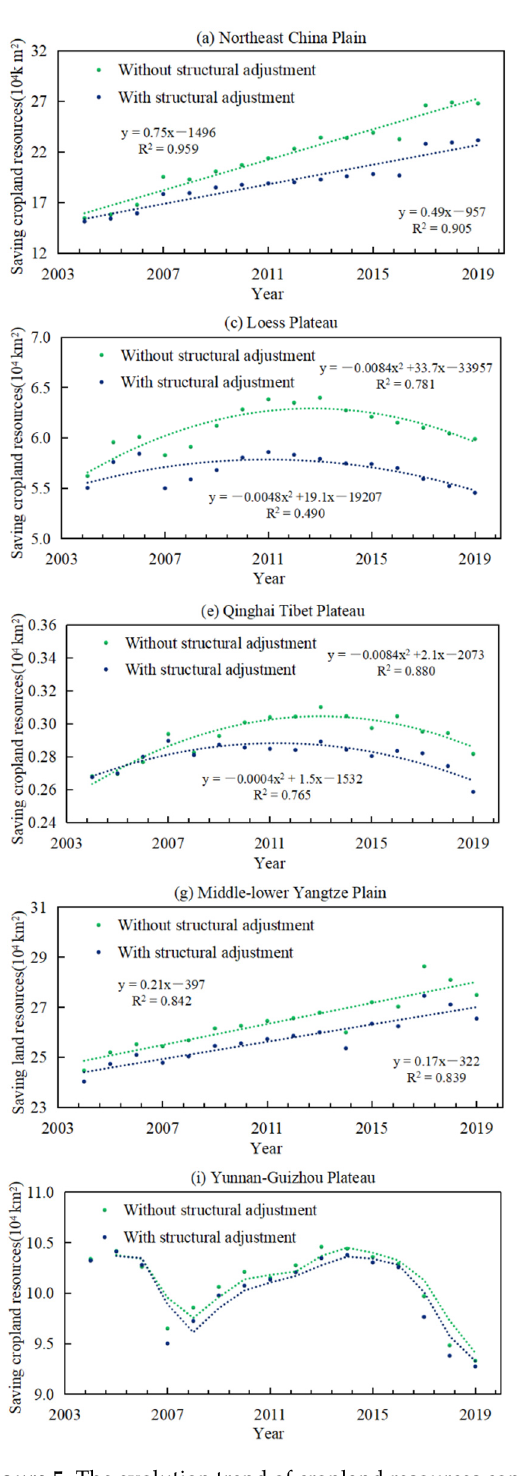
Figure 5. The evolution trend of cropland resources consumption with or without the adjustment of grain planting structure. ( a , b , d , g , j ) fit the linear approximation, ( c , e , f , h ) are described by polynomials, ( i ) uses the moving average method to express the evolution trend. y represents the cropland resources consumption with or without the adjustment of grain planting structure, x represents the year, R 2 expresses the explanatory degree of the relationship between the x and y variables. The values of R 2 range from 0 to 1. The higher the value, the closer relationship between the x and y variables. Green and blue line are fitted curve, which means the evolution trend of cropland resources consumption without structural adjustment or with the structural adjustment, respectively.